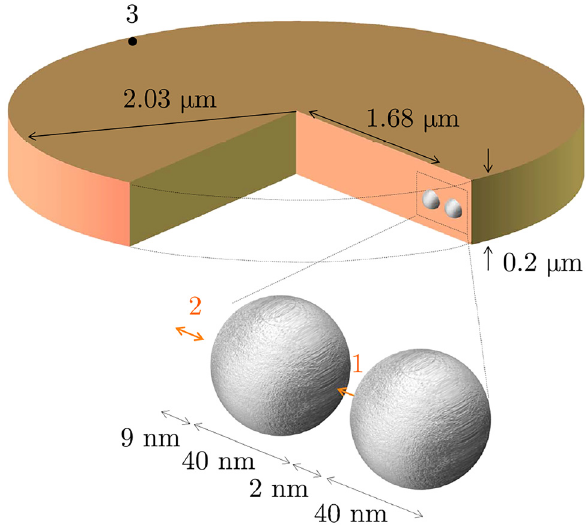
Figure 1: Sketch of the hybrid metallodielectric structure we treat: a dielectric microdisk resonator with a metallic dimer antenna placed on top. The positions of the two emitters are indicated by points 1 and 2, while the field evaluation point used later is indicated as point 3.